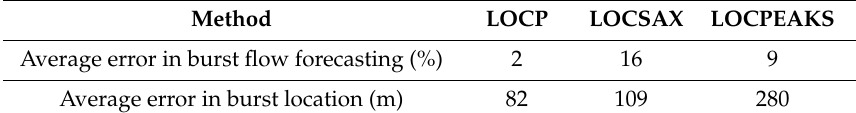
Table 2. Campos do Conde results for leaked flow and distance.